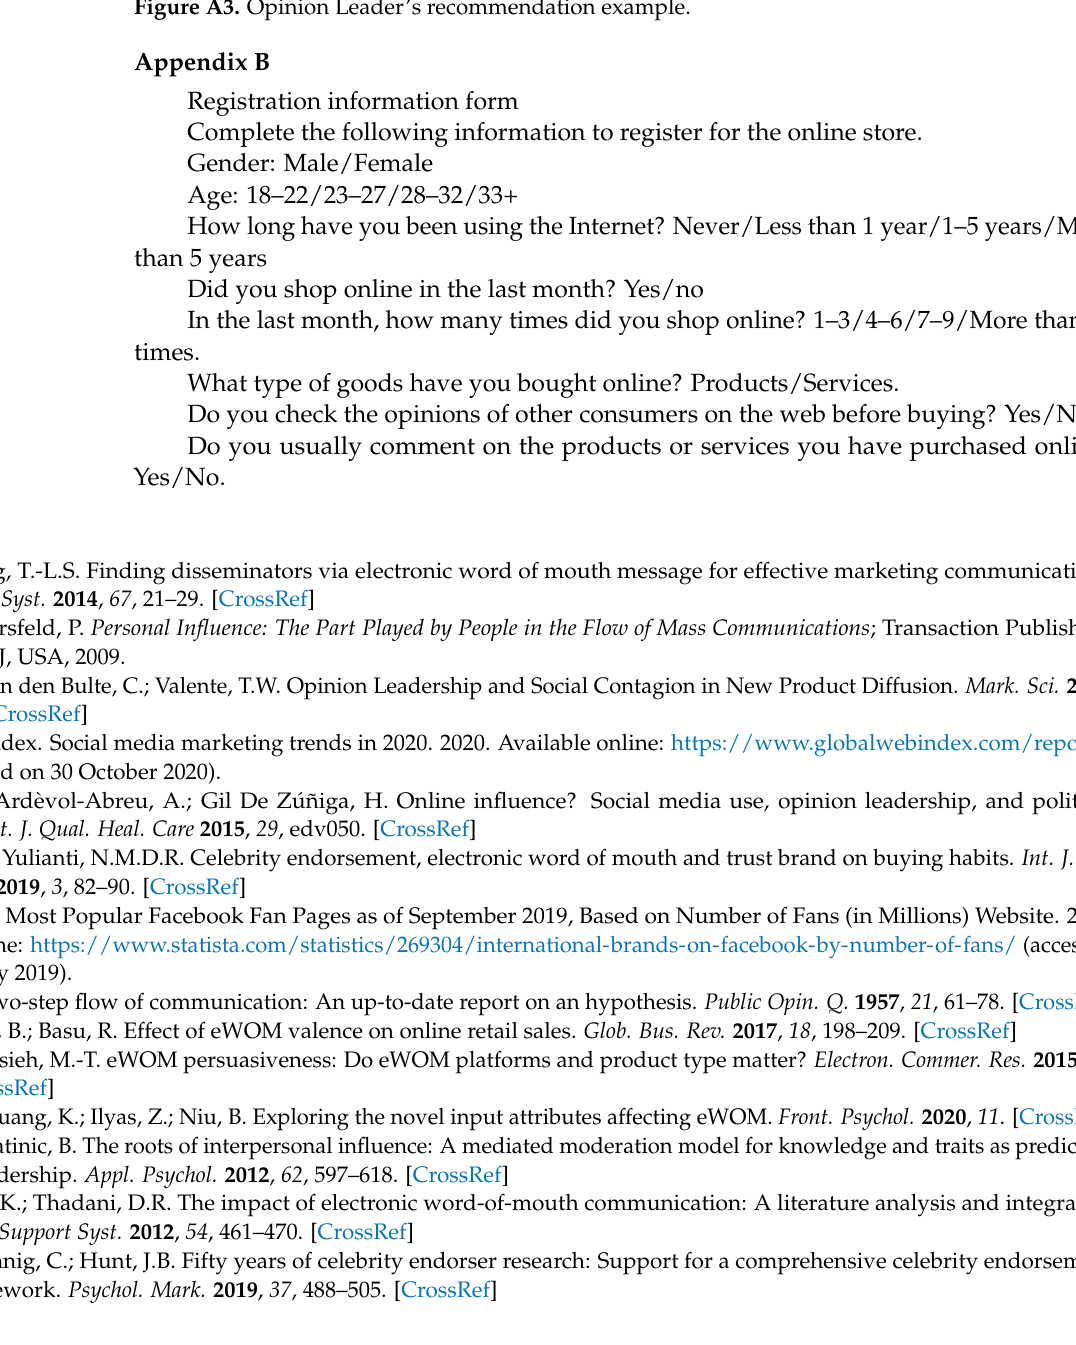
Figure A3. Opinion Leader’s recommendation example.